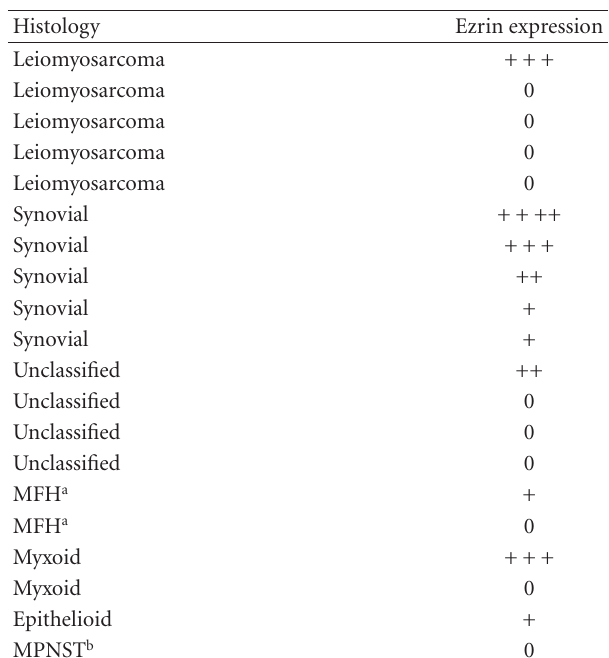
Table 3: Ezrin expression according to histology.